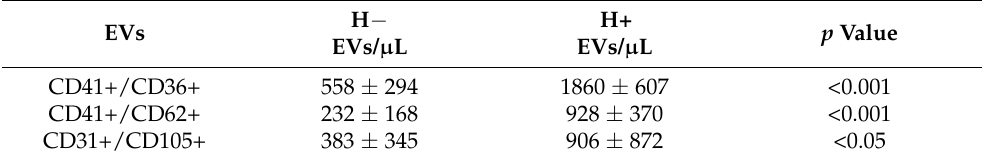
Figure 4. Counts of large EVs in hemolytic (H+) and non-hemolytic (H − ) cord blood plasma samples. Platelet (( A ) CD41+CD36+), activated platelet (( B ) CD41+CD62+), and endothelial (( C ) CD31+CD105+) EV counts in hemolytic (H+; squares, n = 7) and non-hemolytic (H − ; circles, n = 23) samples. The medians are shown. * p < 0.05, *** p < 0.001. Table 3. EV counts of hemolytic (H+) and non-hemolytic (H − ) cord blood plasma samples presented as a mean ± SD.